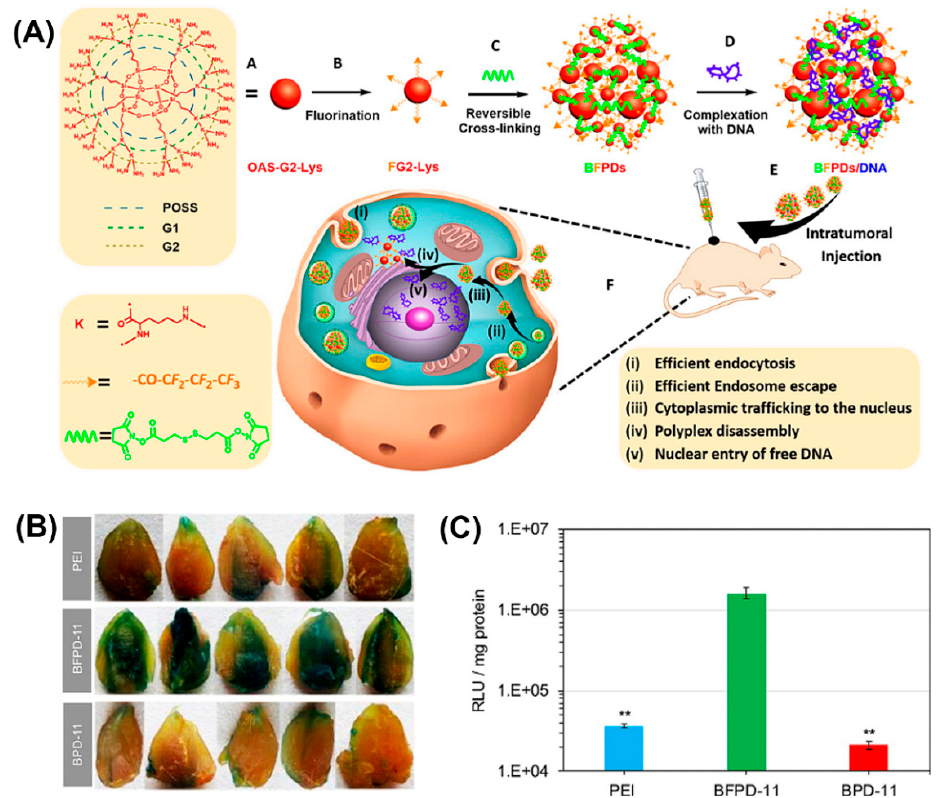
Figure 16. ( A ) Schematic illustrating chemical structure and preparation method of BFPDs peptiplexes for intratumoral gene delivery and their transport across the different intracellular barriers. Transfection efficacy of ( B ) pCMV - β - gal and ( C ) pSC-Luc, in mouse muscles after